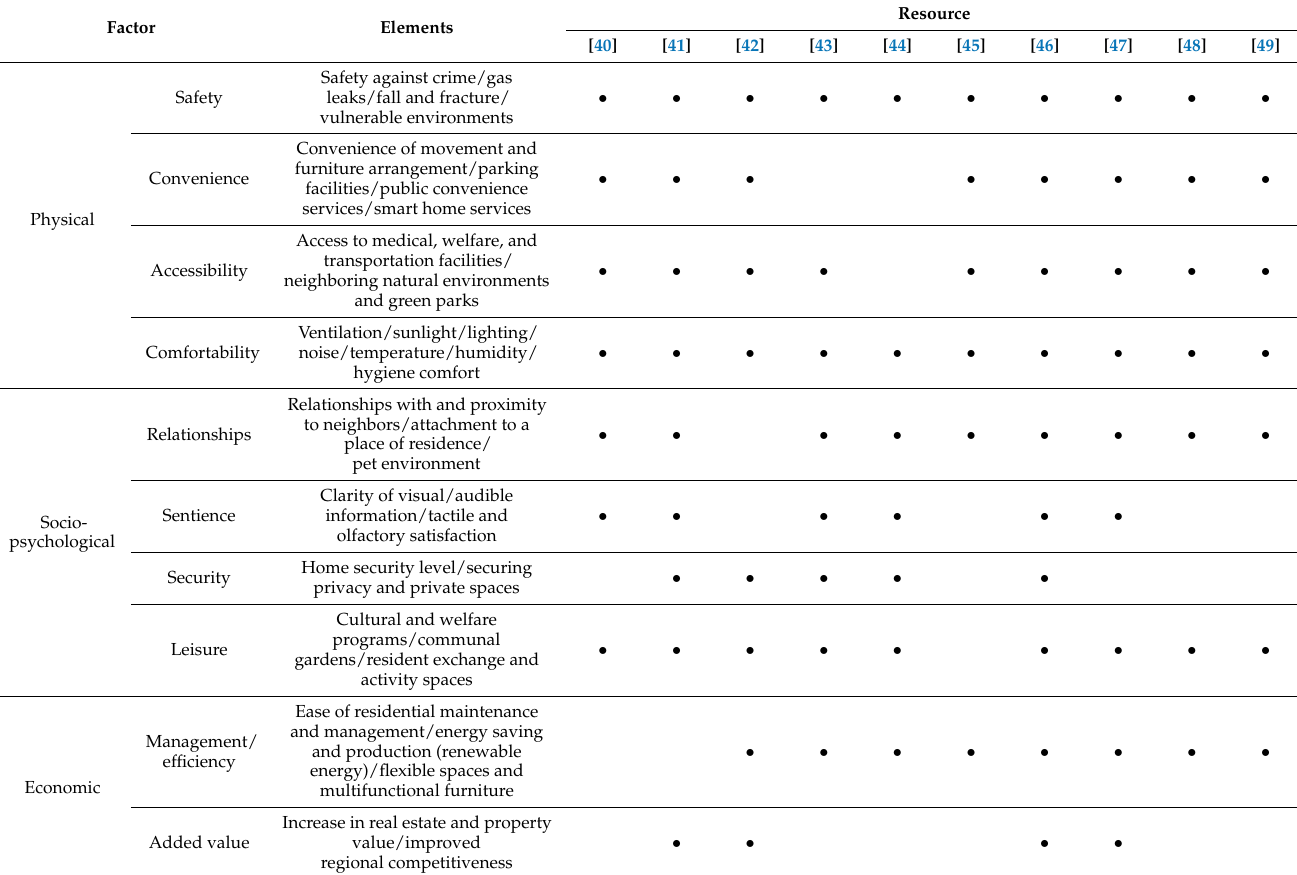
Table 2. Residential environmental factors related to improving